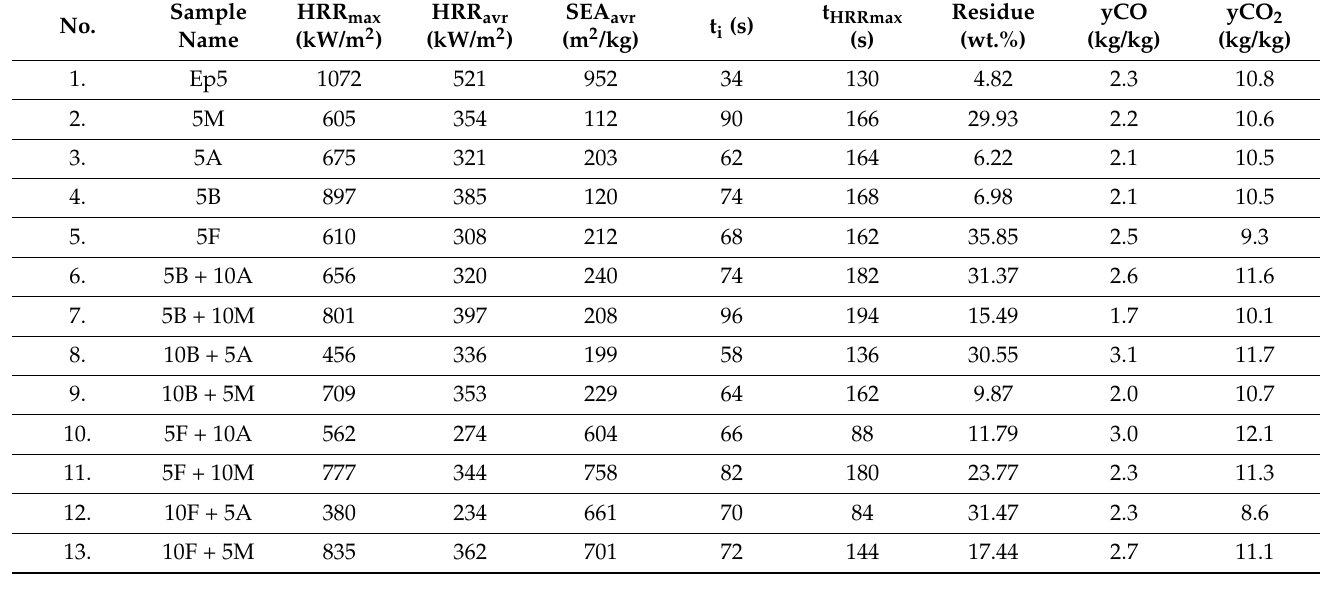
Table 3. Thermokinetic properties of epoxy materials produced from unmodified and modified Ep5 exposed to heat flux equal to 30 kW/m 2 (piloted ignition).